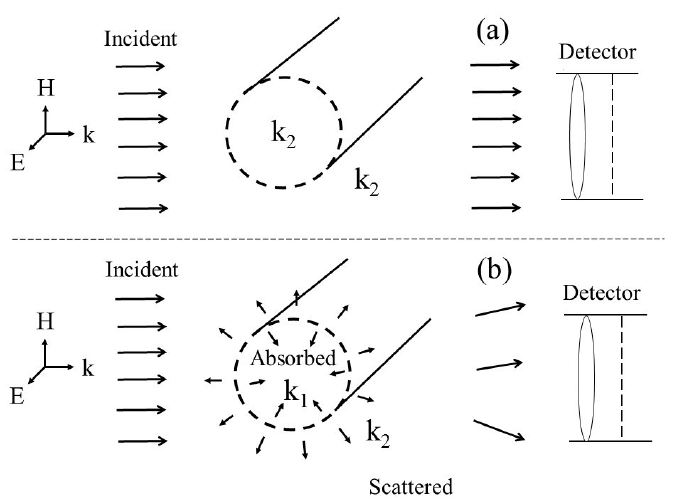
√ (cid:101) 2 µ 2 is same as √ (cid:101) 1 µ 1 (of cylinder) is not the same as k 2